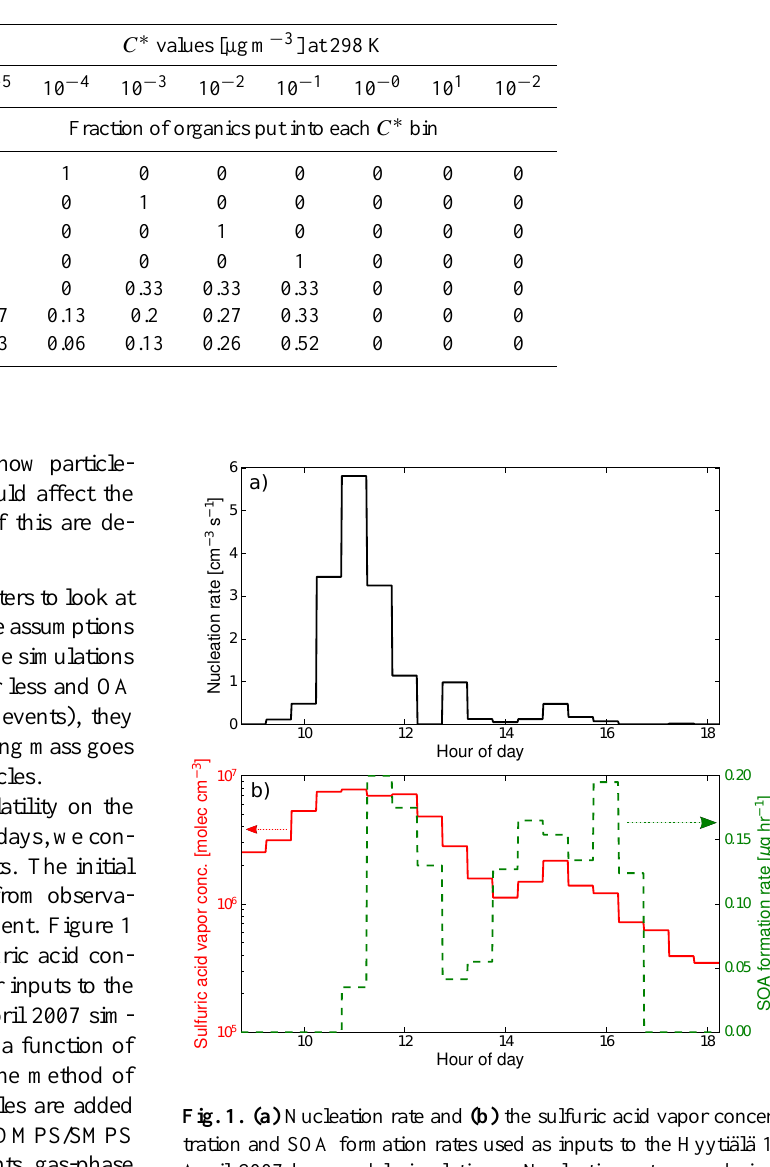
Table 2. Various assumptions of SOA volatilities used in TOMAS microphysics model.